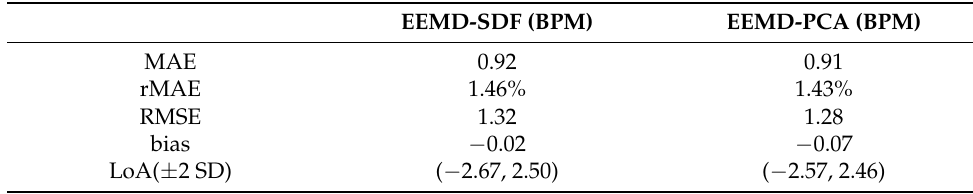
Table 4. The estimated HR using EEMD-SDF and EEMD-PCA.